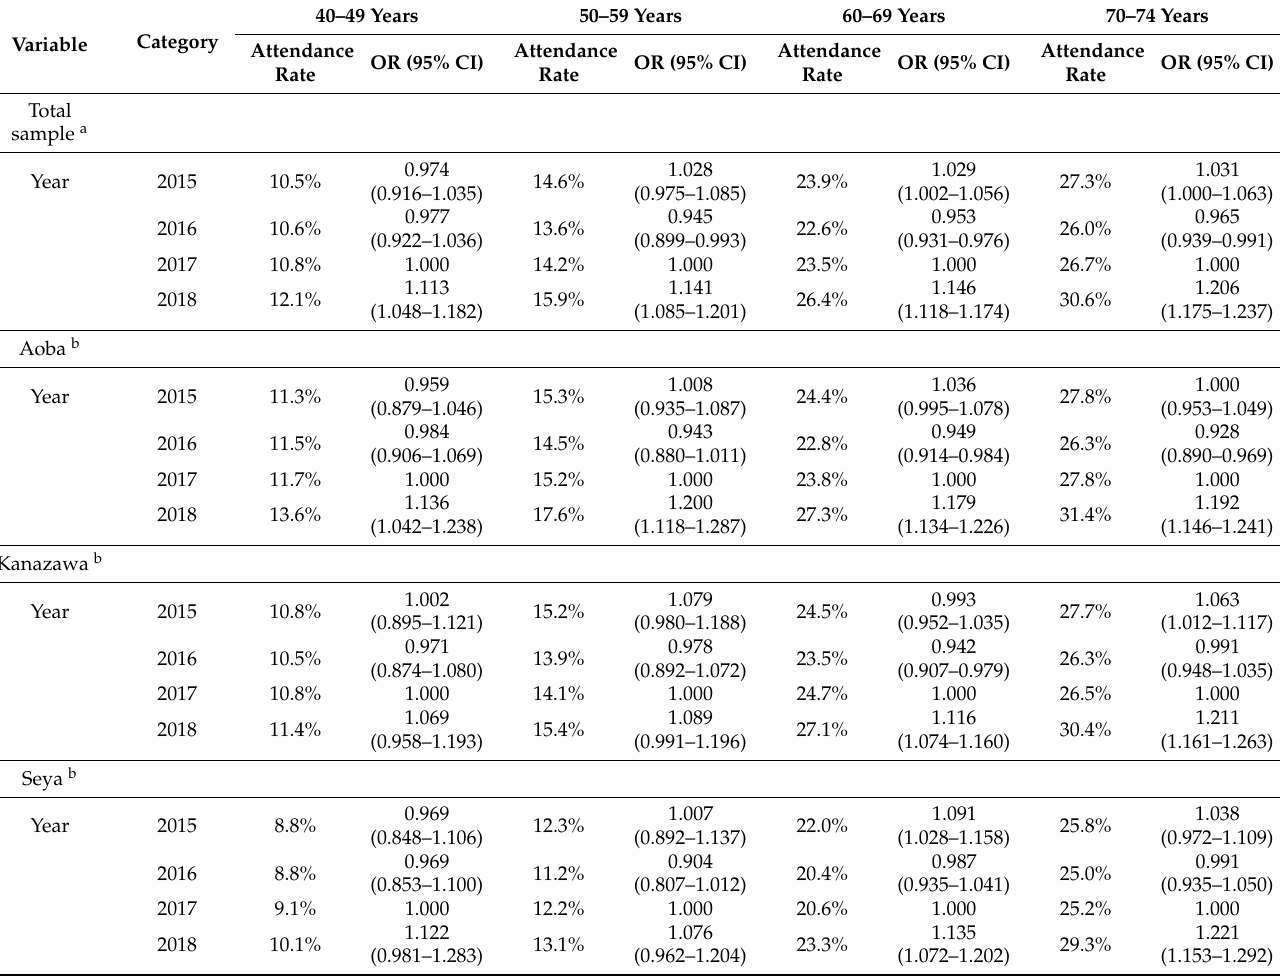
Table 5. Stratified analysis by age for increases in specific health check attendance after the out-of-pocket cost removal intervention: total sample and subgroups by residential